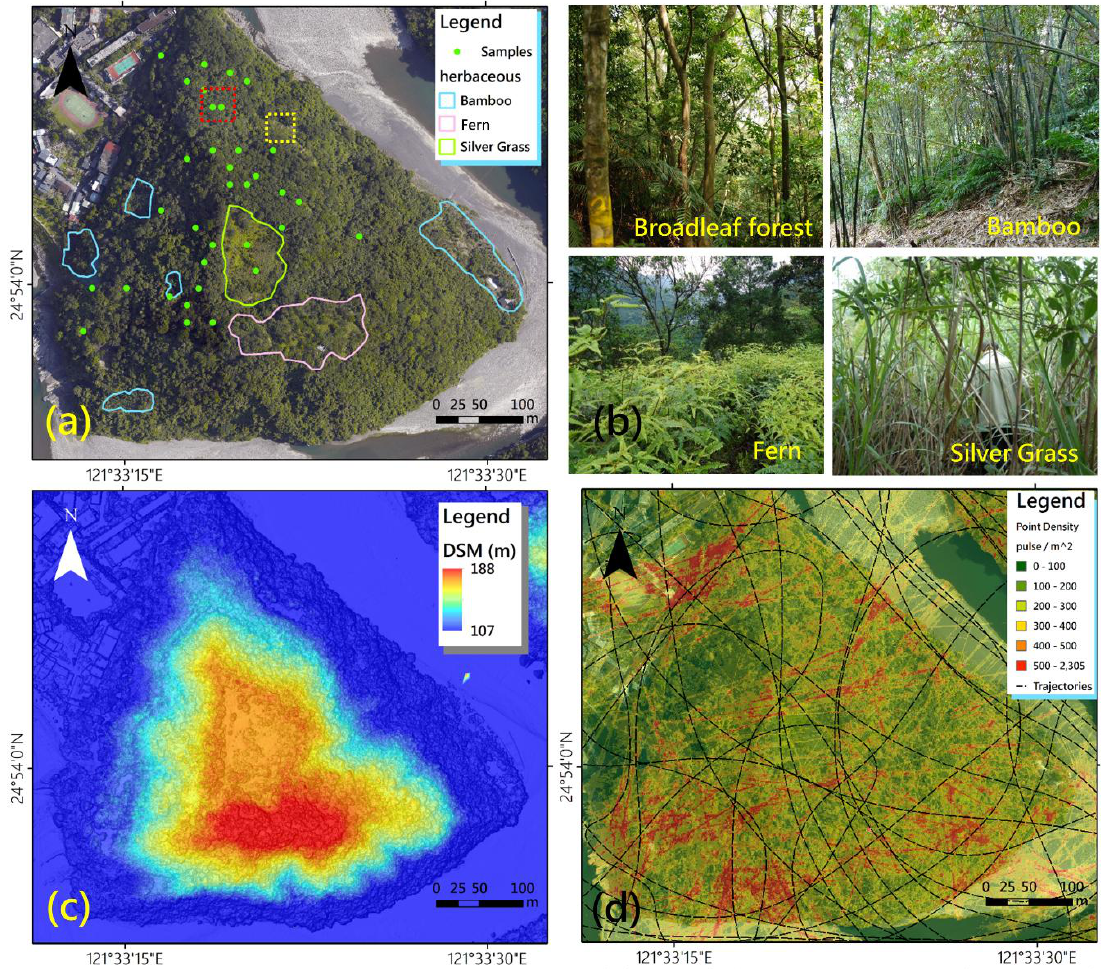
Figure 1. Tropical broadleaf forest study area in Xindian District, New Taipei City, Taiwan. ( a ) Aerial photographs. The vegetation distribution in the figure includes tropical broadleaf forests, bamboo forests, ferns, and silver grass. The green dots indicate 35 sample regions examined using in-situ measurements. ( b ) In-situ photographs, including broadleaf forests, bamboo forests, ferns, and silver grass; ( c ) DSM figure (LiDAR generation) with additional shadow effects; ( d ) Laser pulse density and flight scanning trajectory.